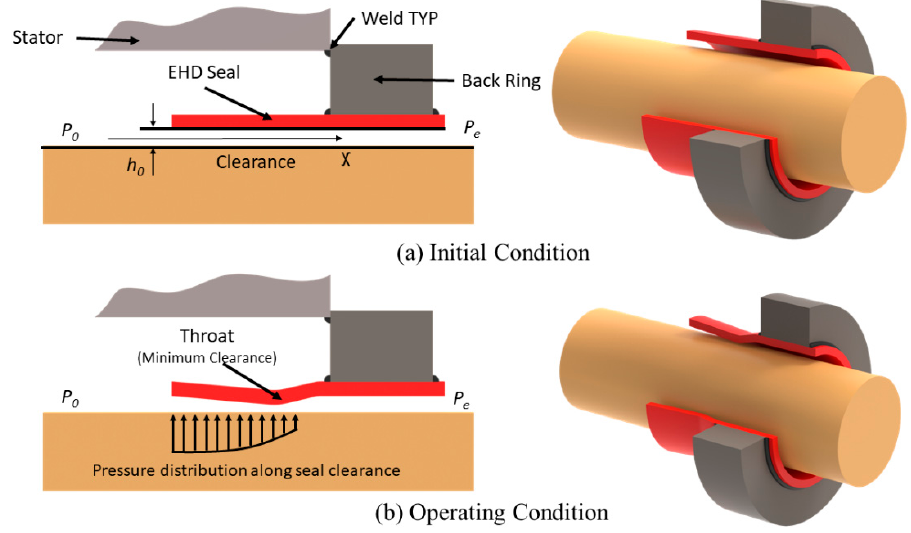
Figure 2. Working mechanism of the proposed EHD seal: ( a ) initial condition and ( b ) operating condition.